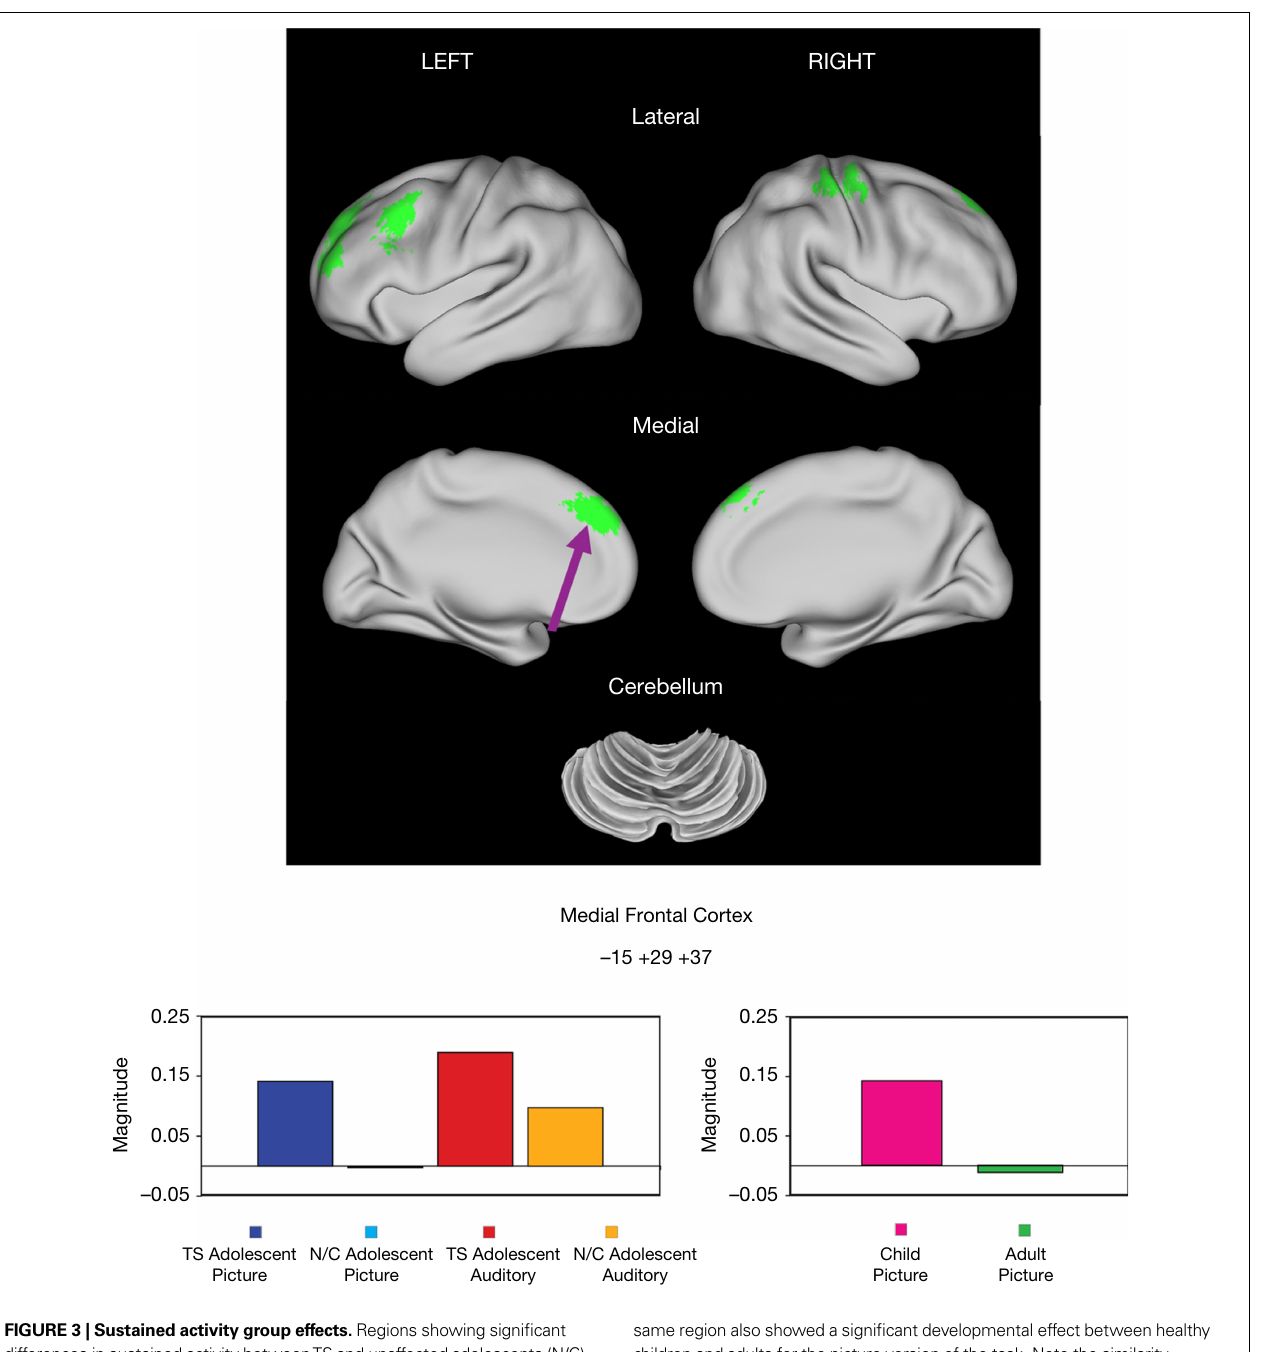
FIGURE 3 | Sustained activity group effects. Regions showing signifi cant differences in sustained activity between TS and unaffected adolescents (N/C) are displayed in green. All signifi cant differences were in frontal cortex. An example of the sustained magnitudes for each adolescent group for each task modality is shown for a medial frontal region (arrow) (left magnitude set). This